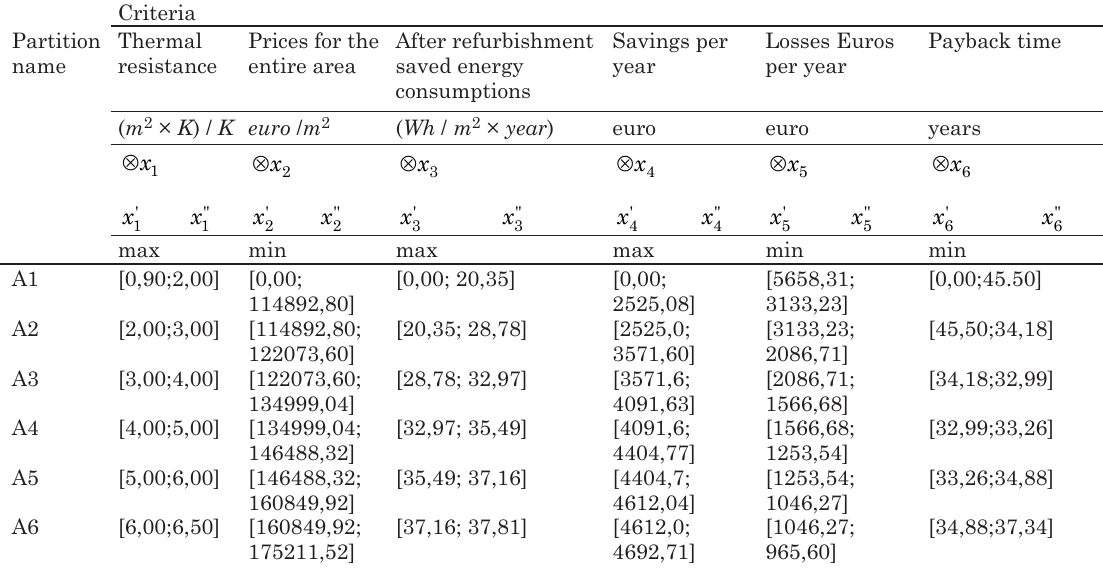
Table 3. Matrix with interval normalization Criteria